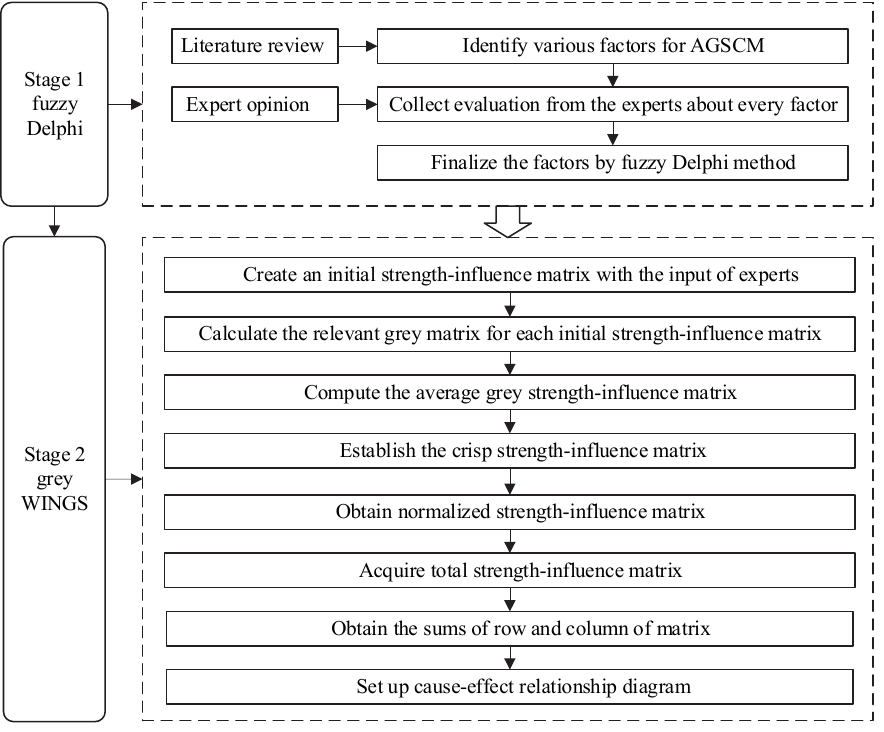
Figure 1. The framework of fuzzy Delphi and grey WINGS.